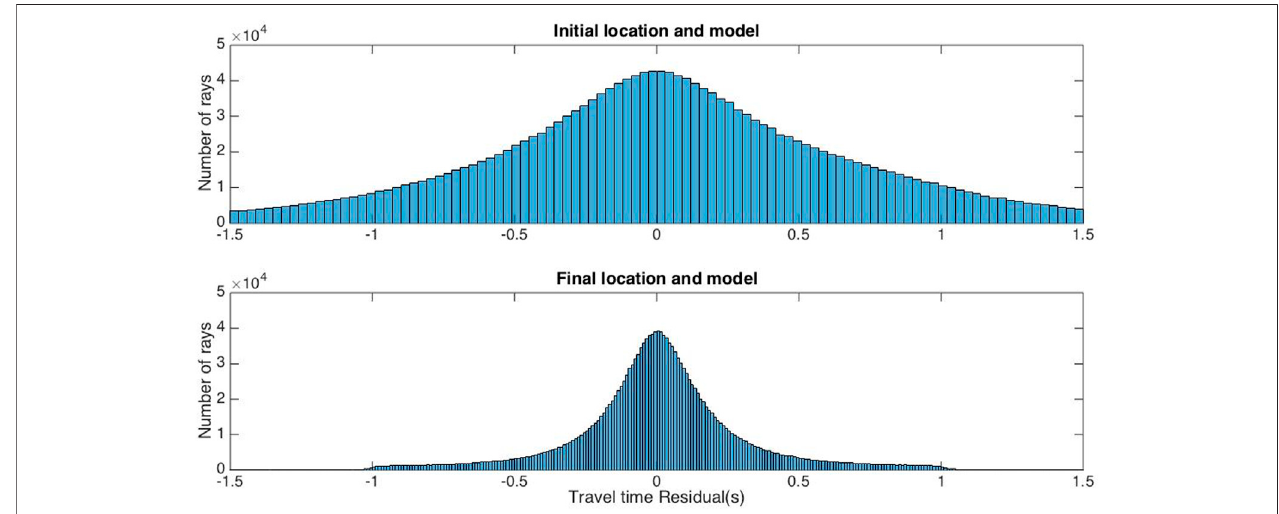
FIGURE 9 | Residual mis fi t improvement. Compilation of the overall number of earthquakes with root-mean-square mis fi t in bins with widths of 0.15s, comparing (top) the starting 1D model to (bottom) the fi nal 3D model.